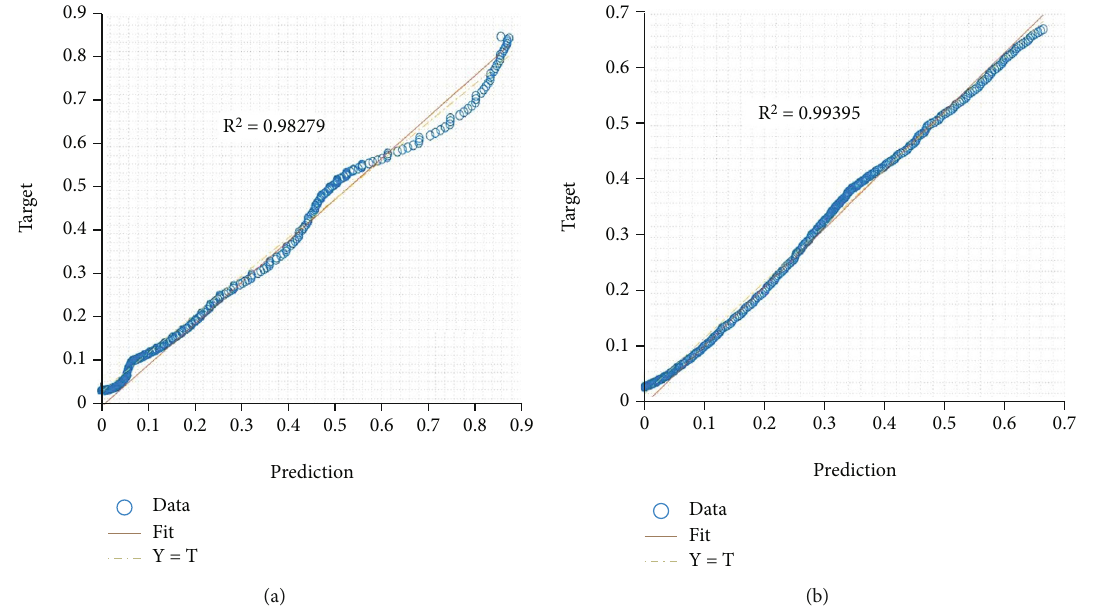
Figure 4: Regression plot of logistic growth model for predicting COVID-19 cases in (a) Australia and (b)